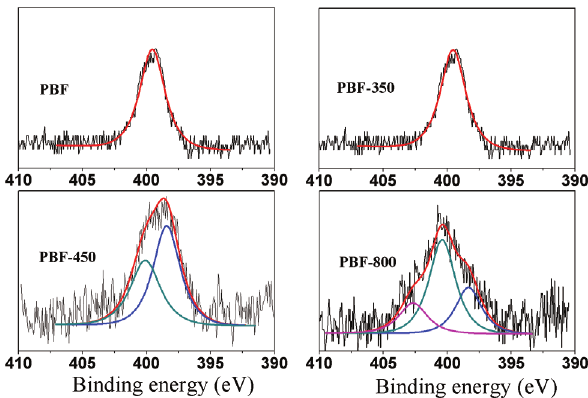
Fig. 2: N 1s XPS spectra of PBP and its chars obtained at various temperatures